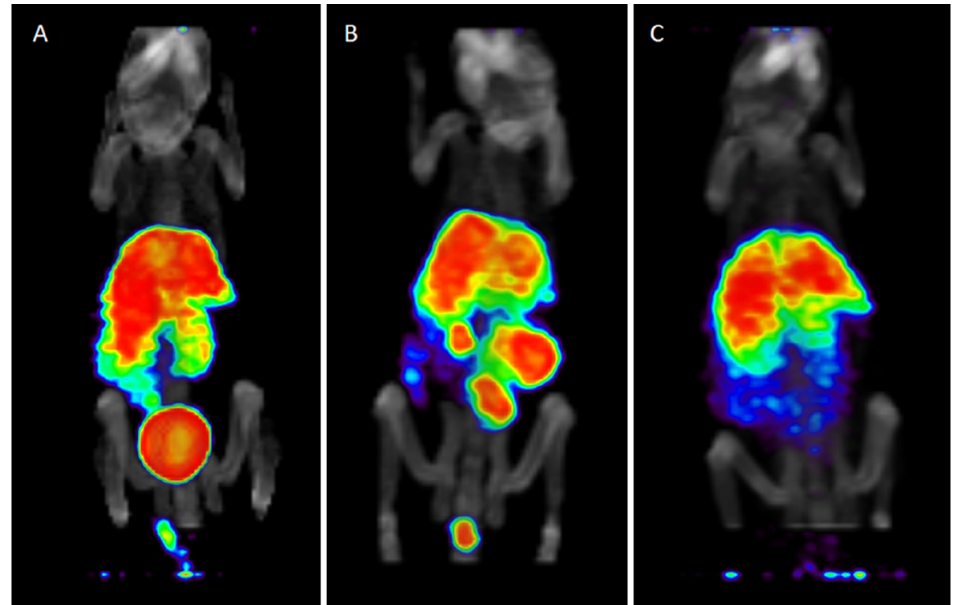
Figure 9. Representative PET/CT images of [ 64 Cu][Cu(DO2A2S)] injected in nude BALB/C mice at ( A ) 1 h, ( B ) 4 h and ( C ) 24 h post-injection by tail vein (%ID/voxels).